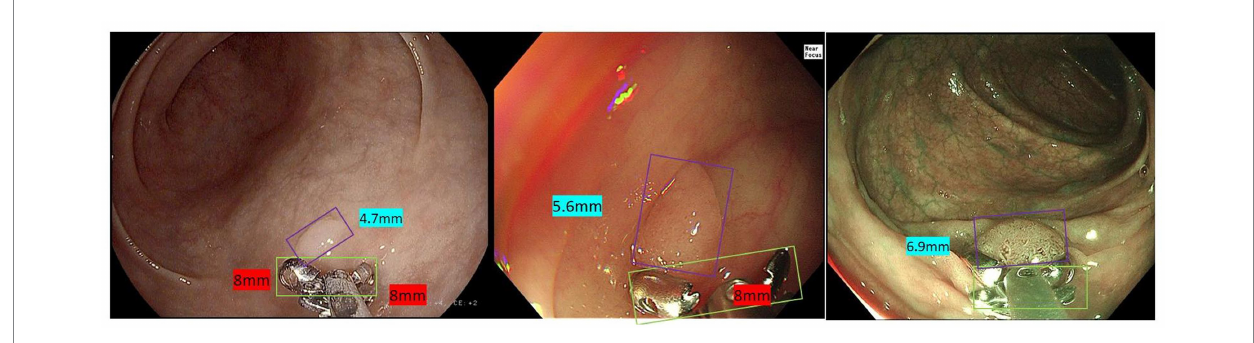
FIGURE 4 Automatic measurement process of the polyp size measurement model.